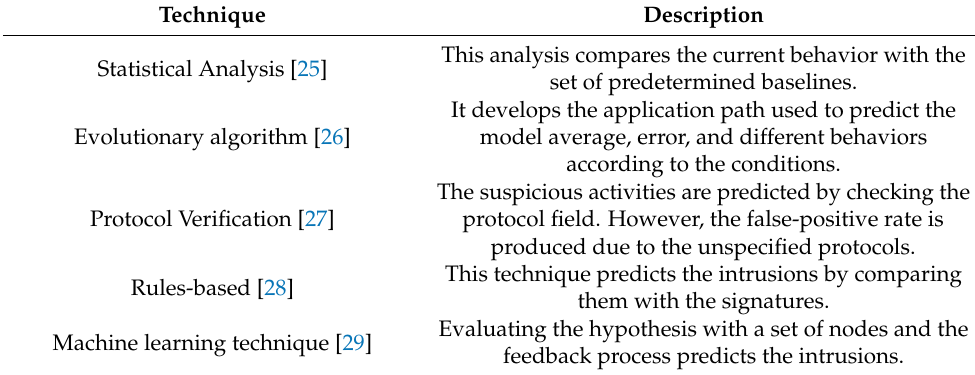
Table 1. Intrusion detection